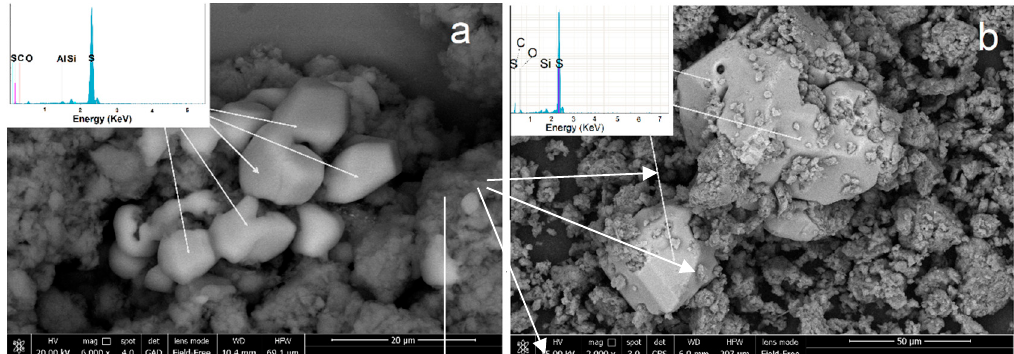
Figure 3. Scanning electron microscopy (SEM) images of Mt-CuPhen exposed to H 2 S for different times: ( a ) 3 days; ( b ) 3 months. The energy dispersive X-ray spectrometry (EDX) spectra reported refer to crystals indicated by arrows.